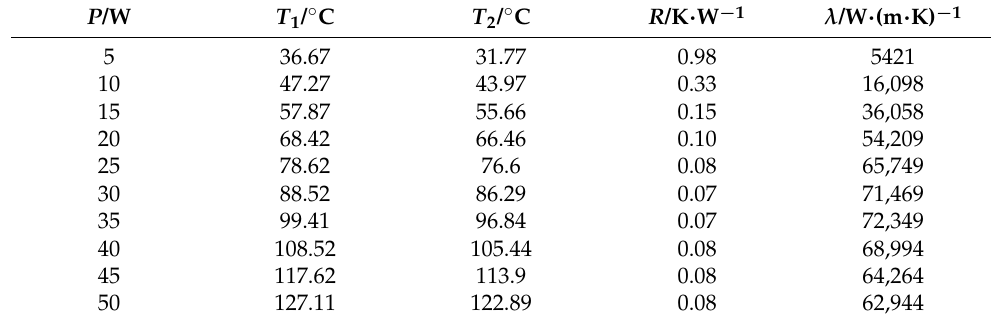
Table 3. The thermal property of the heat